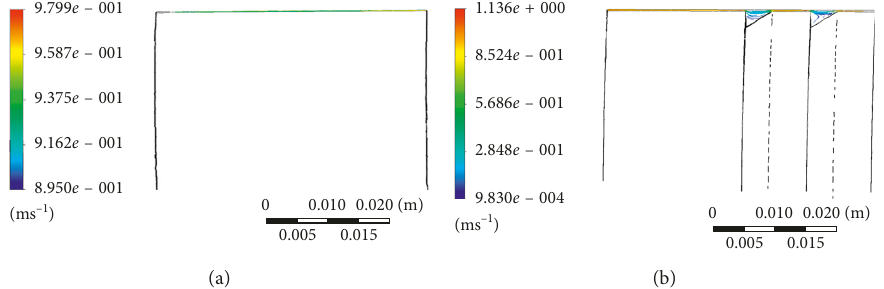
Figure 13: Piston section leakage streamline: (a) standard piston; (b) bionic piston.